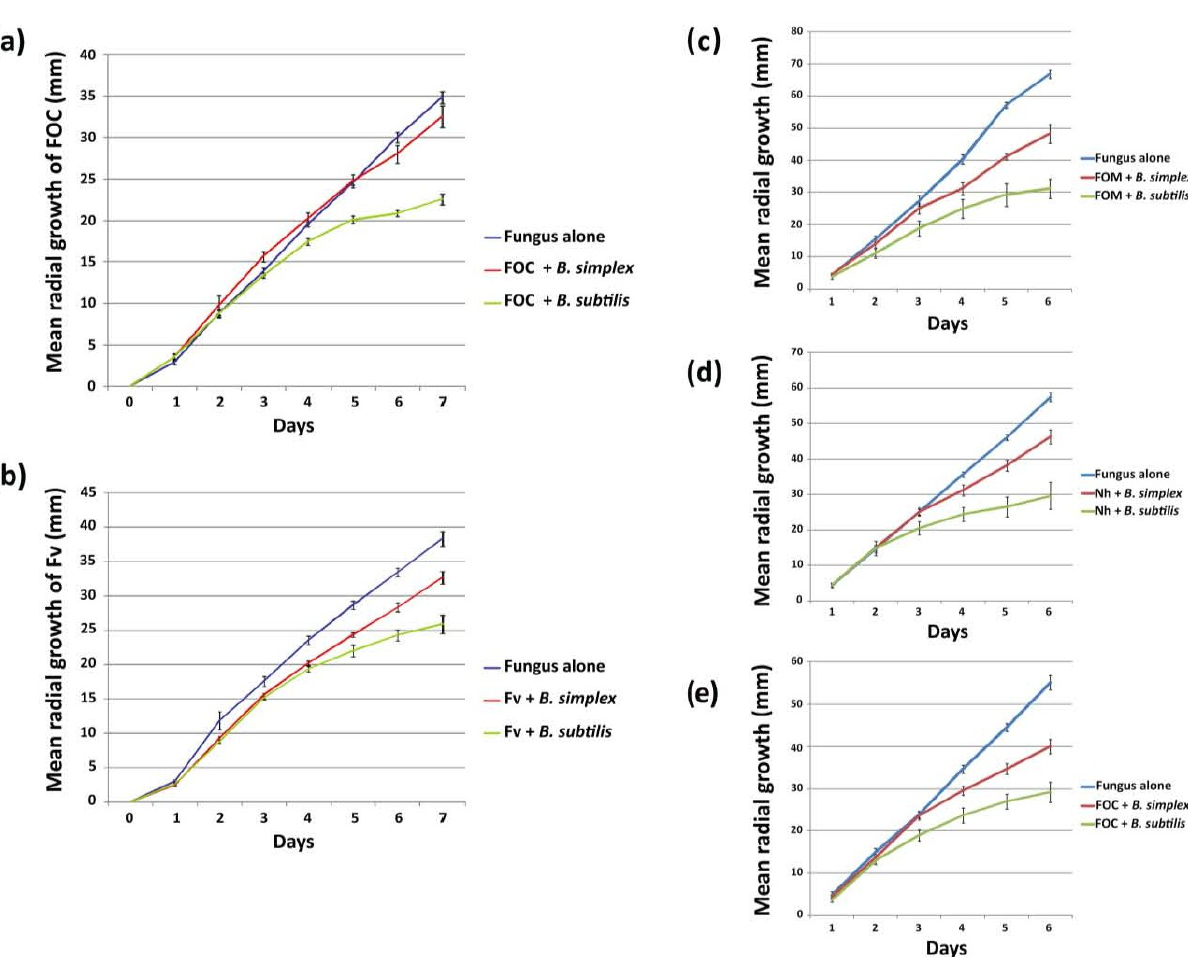
Figure 6. Effect of B. simplex 30N-5 (red line) and B. subtilis 30VD-1 (green line) on the growth of fungi on either PDA ( a,b ) or V8 agar ( c – e ). The fungal species tested were: (a) Fusarium oxysporum f. sp. conglutinans PHW 808 (FOC); (b) Fusarium verticillioides FV3 X0042 (Fv); (c) Fusarium oxysporum f. sp. matthioli PHW 726 (FOM); (d) Nectria haematococca 77-13-4 (Nh); and (e) Fusarium oxysporum f. sp. conglutinans PHW 808 (FOC). The blue line illustrates the radial growth of the fungus in the absence